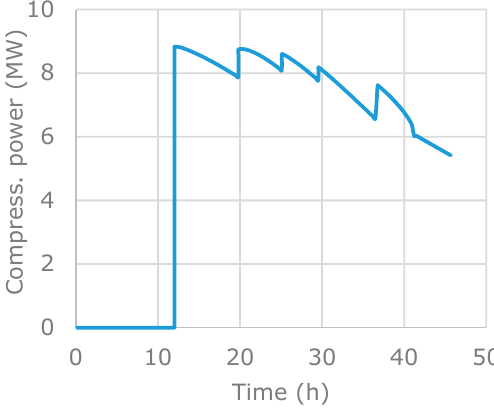
Figure 15. Compression ratio (adiabatic unloading).